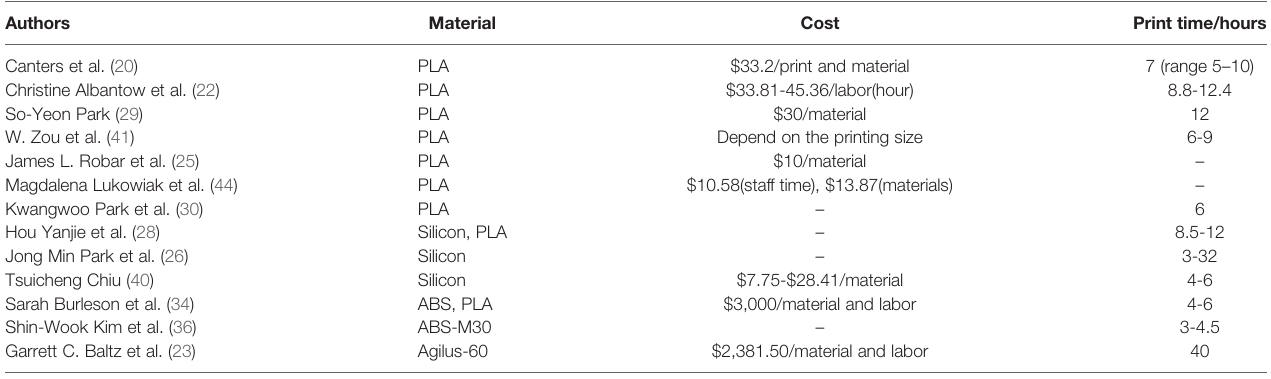
TABLE 4 | Cost-effectiveness of the 3D-printed